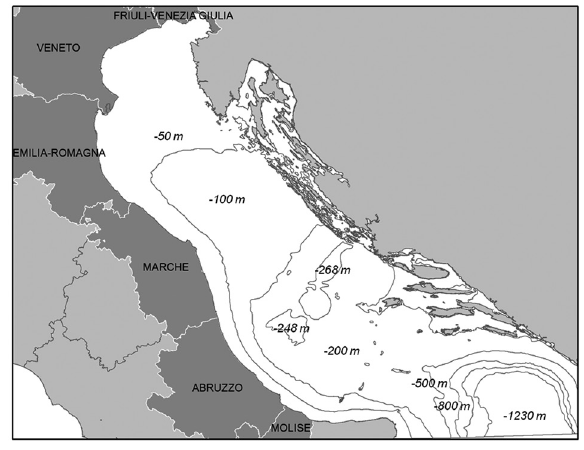
Fig . 1. – Italian regions and bathymetry of the Northern Adriatic Sea (GSA